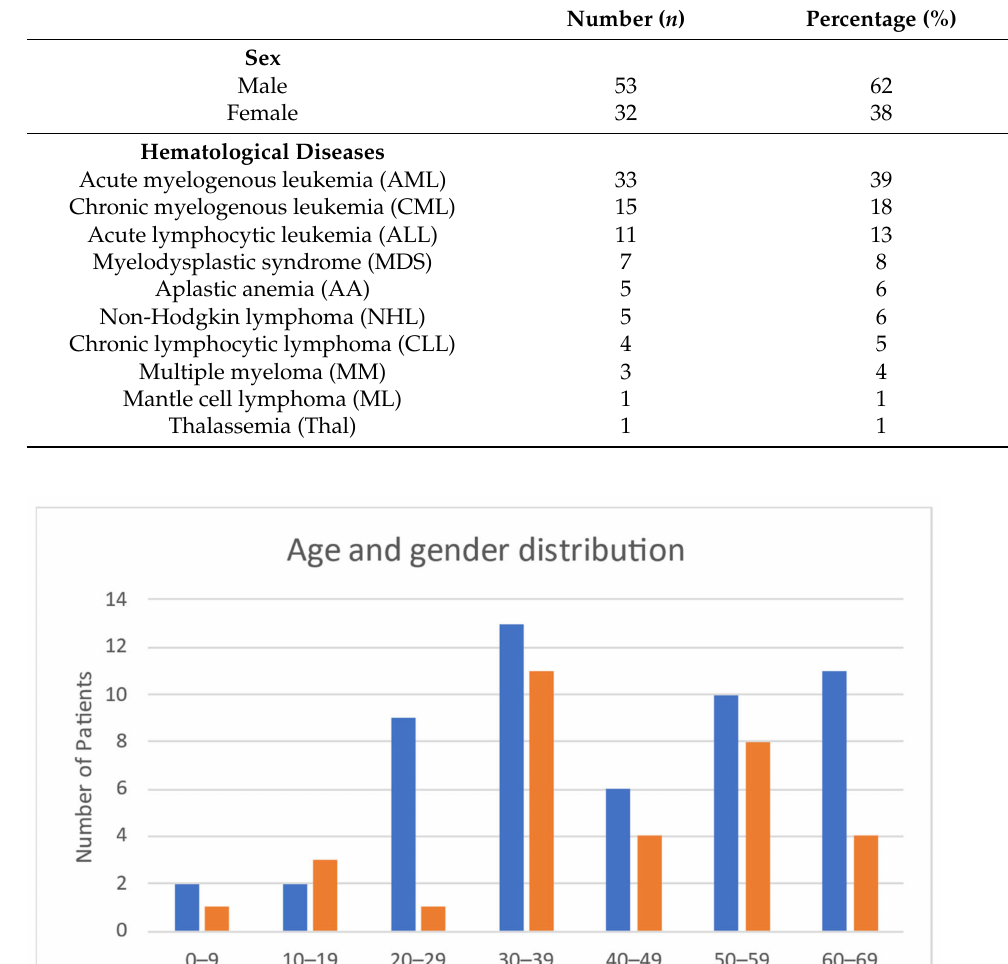
Table 3. This table shows the distribution of patients regarding gender and hematological diseases.